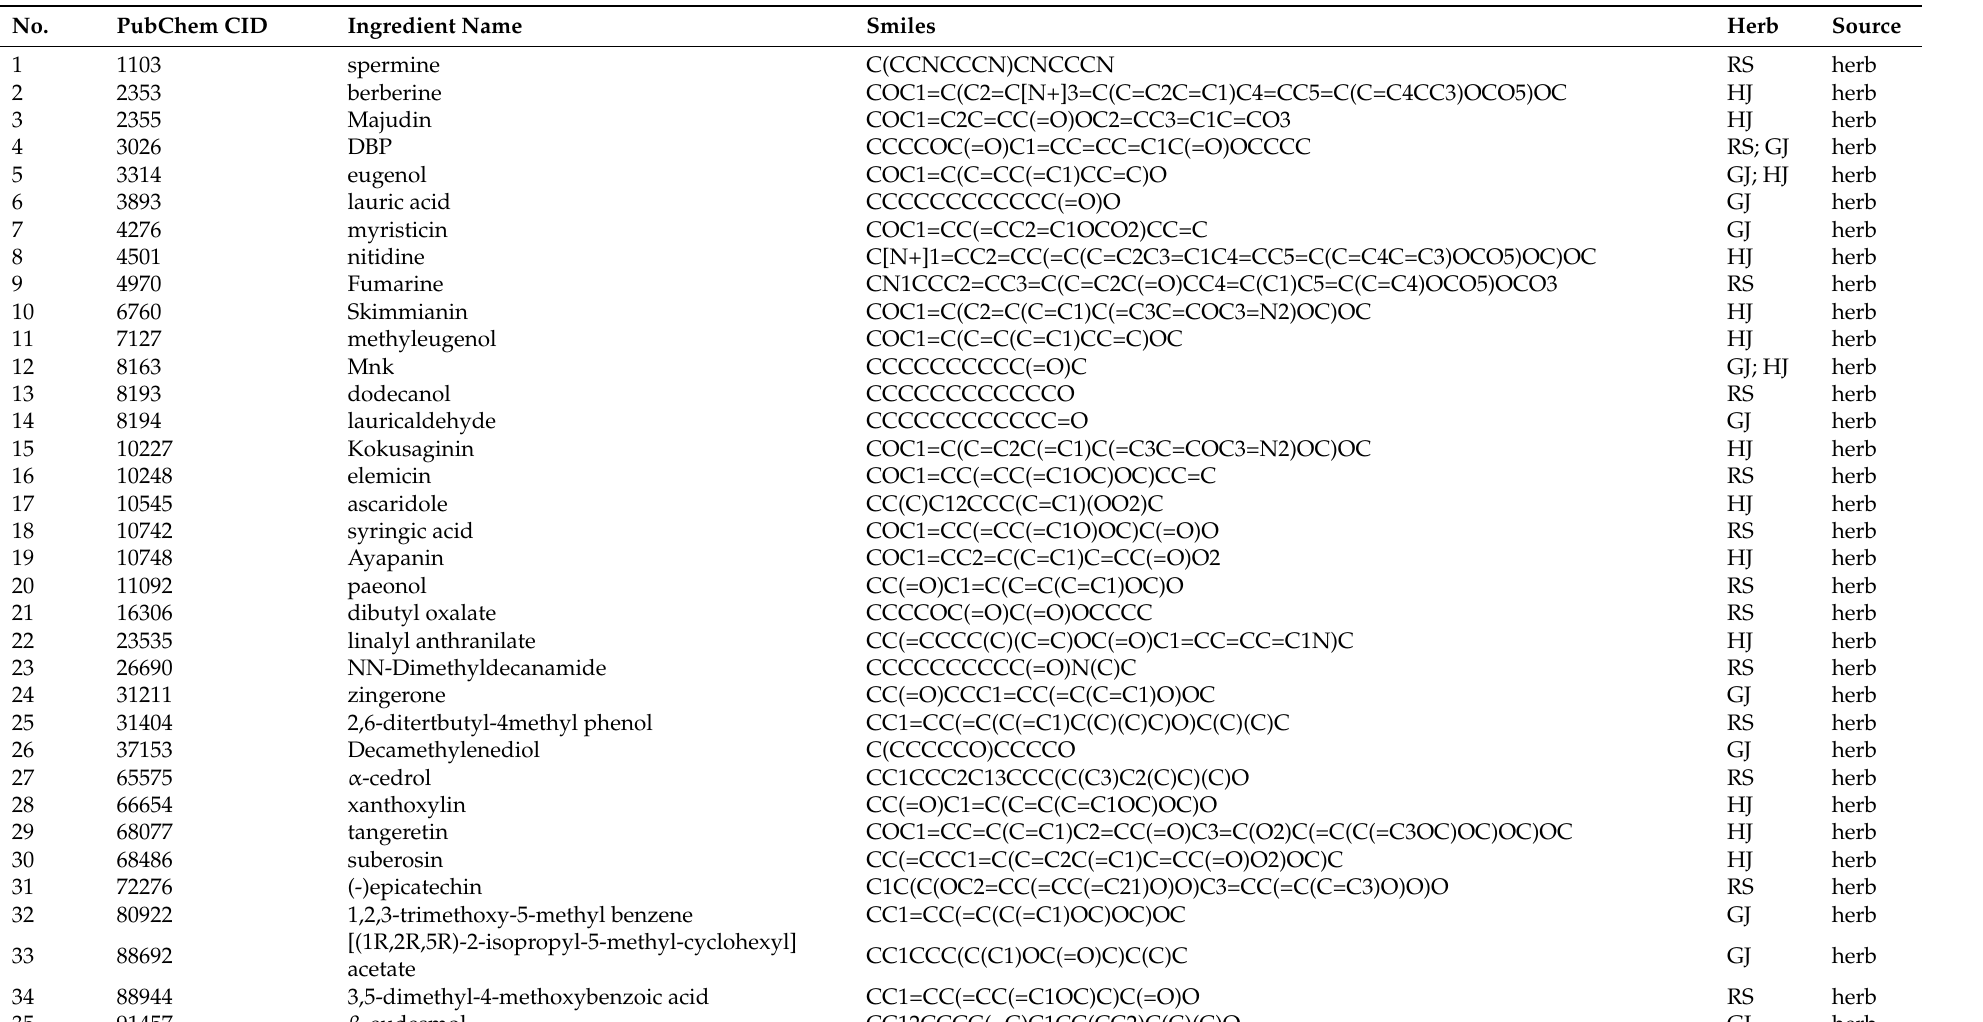
Table 1. Compounds information of Dajianzhong